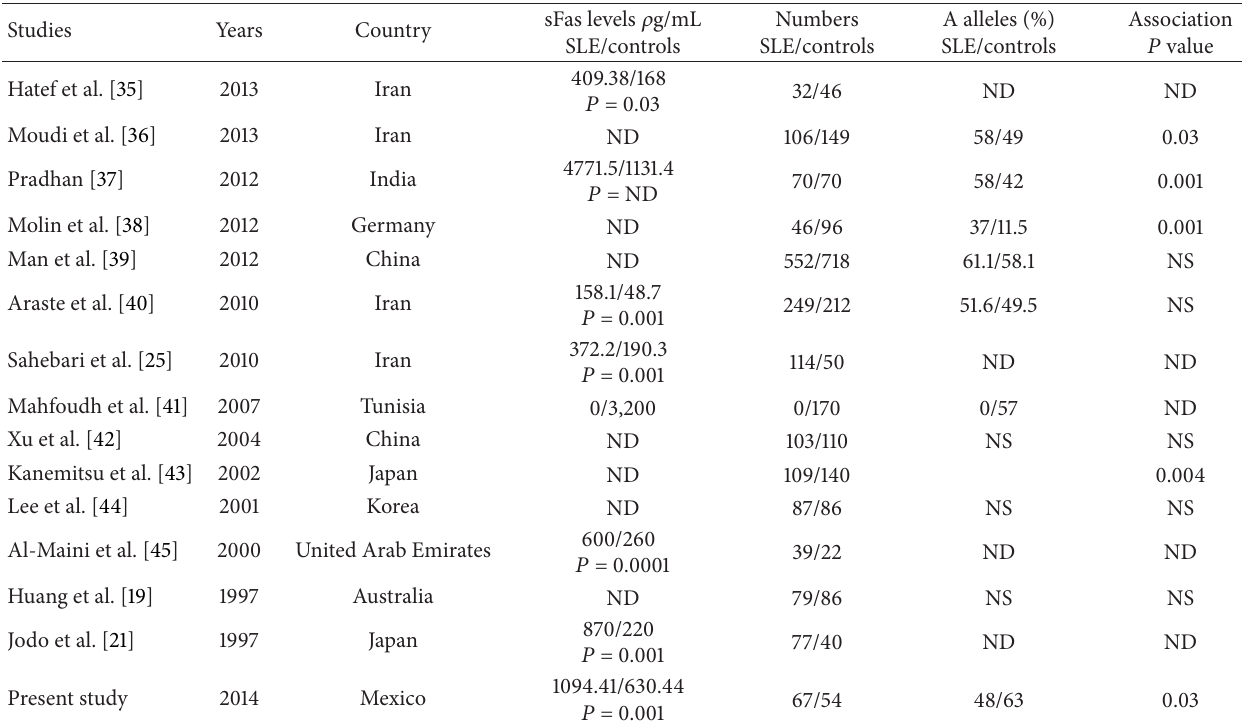
Figure 9: TUNEL assays in renal tissue of LN patients and HS. Positive apoptotic cell exhibited nuclei tagged in green. (a) HS biopsies. (b) and (c) show a representative of LN. The nuclei of nonapoptotic cell were red-tagged. Table 4: Characteristics of the individual studies of the − 670 (A/G) Fas polymorphism in SLE and sFAS adapted from [33,